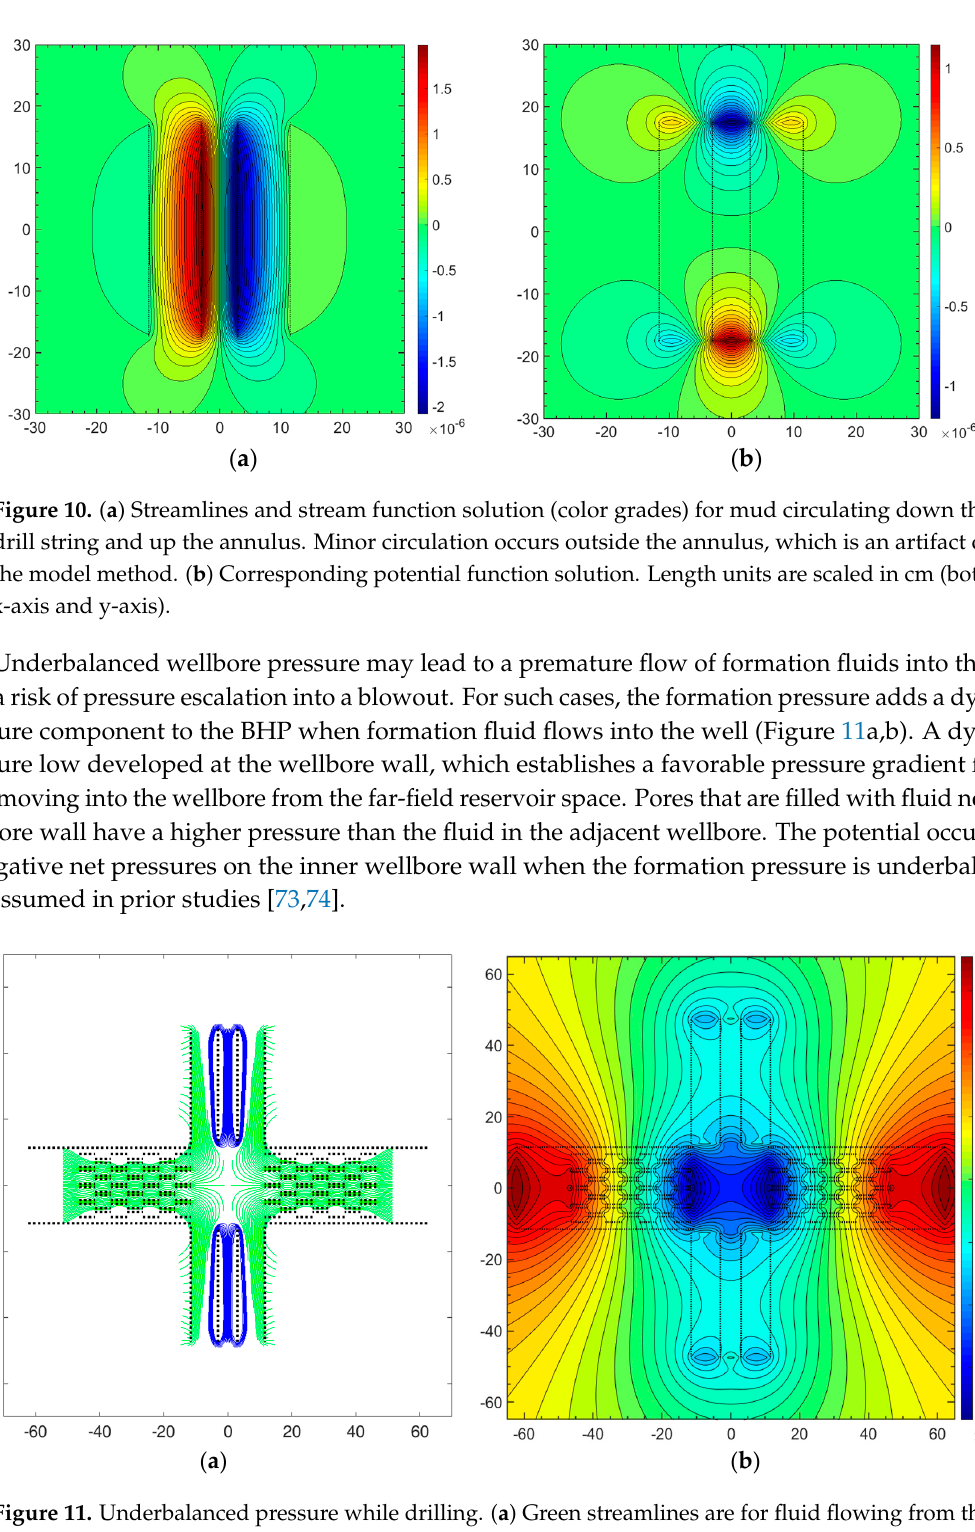
Figure 11. Underbalanced pressure while drilling. ( a ) Green streamlines are for fluid flowing from the penetrated formation to the fluid annulus between the drill string and the wellbore. Blue streamlines are for circulating drilling mud. Due to drilling mud pressure deficit (underbalance) native pore fluid from the formation can move up the annulus. Flow field is solved using a stream function describing the composite flow field. ( b ) Pressure field obtained by solving the corresponding potential function scaled in units of cm 2 s − 1 (Case 3, Table 1). Length units are scaled in cm (both x-axis and y-axis).